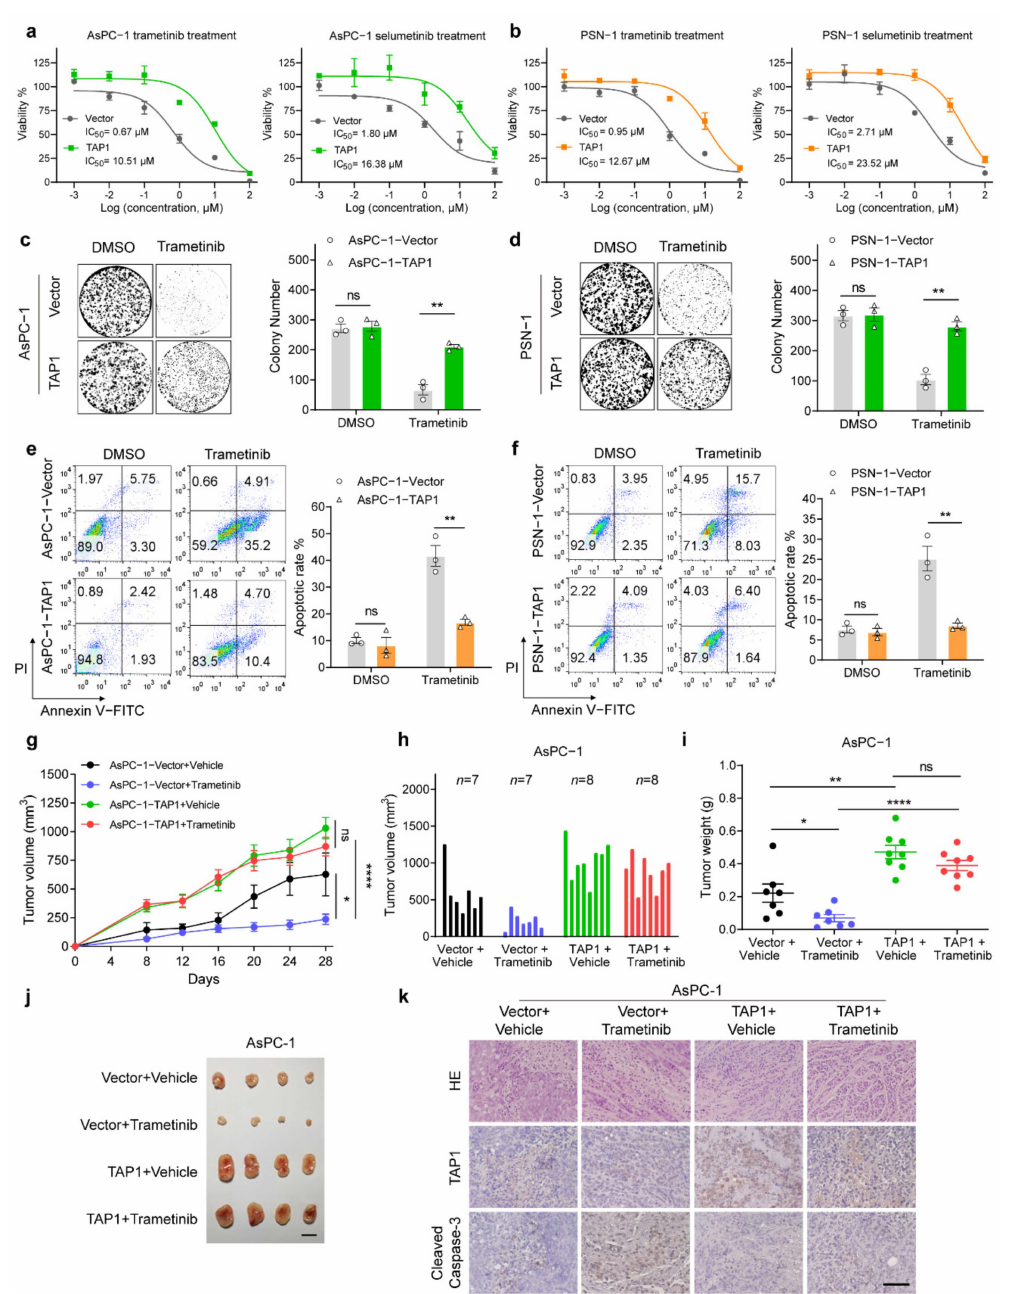
Figure 4. Overexpression of TAP1 renders PDAC cells more resistant to MEKi in vitro and in